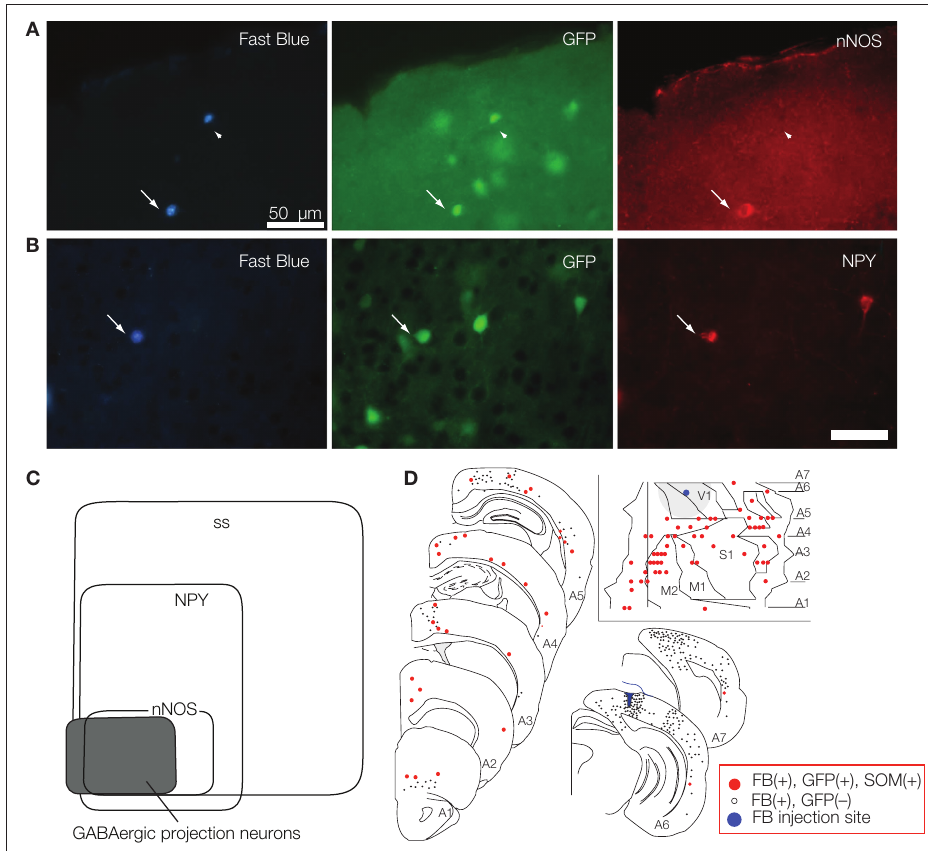
FiGure 2 | Following FB injection into a visual neocortical area of the GAD67-GFP mouse, we found temporal neocortical areas that contained FB- and GFP-double-labeled cells but few FB-single-labeled cells. Most of these double-labeled neurons showed immunoreactivity of somatostatin, neuropeptide Y (A) , and nNOS (B) . A Venn diagram in (C) shows the relationship between the immunoreactivity and the GABAergic projection neurons in the neocortex. (D) Distribution of SS-positive GABAergic projection neurons were revealed by FB injection into the neocortex V1 and represented on the mouse-flattened cortical map and serial frontal sections. Each small gray filled circle represents 20 FB-single-labeled neurons. Each red-filled circle indicates an FB-, GFP- and SS-positive neuron. Blue marker and gray large circle (insets) shows the FB injection site and cortical region within 1.5 mm from the FB injection site, respectively. Calibration bar in (B) is 50 μm. (C,D) Adapted from Tomioka et al.